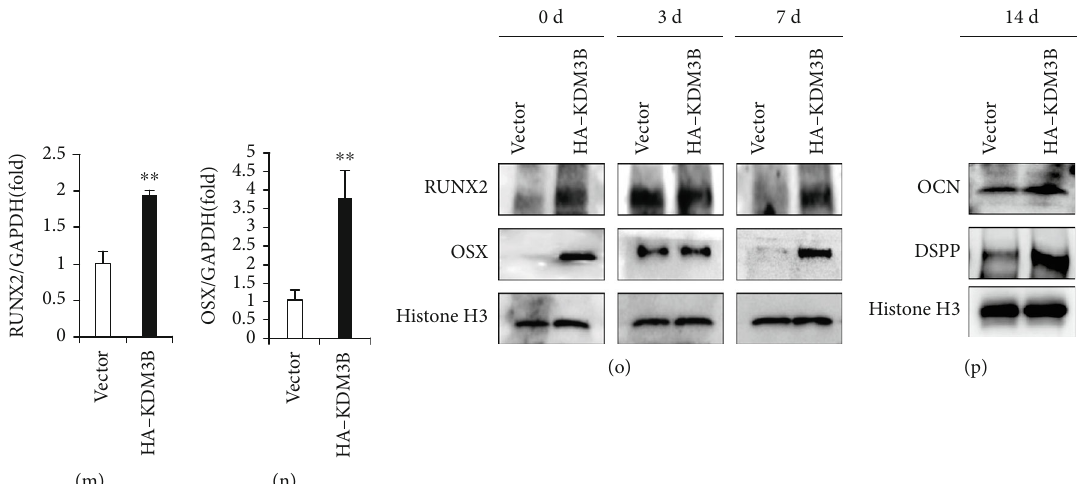
Figure 1: KDM3B enhanced the osteo-/odontogenic di ff erentiation potential of SCAPs. (a) The knockdown e ffi ciency of KDM3B in SCAPs was tested by western blot. (b) KDM3B knockdown signi fi cantly depressed the ALP activity in SCAPs. (c) The Alizarin red staining and (d) the quantitative calcium analysis showed that KDM3B knockdown reduced the mineralization capacity of SCAPs compared with the control group. (e, f) Real-time RT-PCR analysis con fi rmed that KDM3B knockdown reduced the expression of (e) RUNX2 and (f) OSX in SCAPs. (g) Western blot analysis showed the expression of RUNX2 and OSX in the KDM3B knockdown group and the control group. Histone H3 served as an internal control. (h) Western blot analysis revealed that the expression of DSPP and OCN was decreased after KDM3B was knocked down. Histone H3 served as an internal control. (i) The KDM3B overexpression was tested by western blot. (j) KDM3B overexpression signi fi cantly enhanced the ALP activity in SCAPs. (k, l) The results of (k) the Alizarin red staining and (l) the quantitative calcium analysis revealed that KDM3B overexpression enhanced the mineralization capacity of SCAPs compared with the control group. (m, n) Real-time RT-PCR analysis revealed that KDM3B overexpression increased the expression of (m) RUNX2 and (n) OSX in SCAPs. (o) Western blot analysis showed the expression of RUNX2 and OSX in the KDM3B overexpression group and the control group. Histone H3 served as an internal control. (p) Western blot analysis revealed that the expression of OCN and DSPP was enhanced after KDM3B was overexpressed. Histone H3 served as an internal control. Statistical signi fi cance was determined using Student ’ s t -test. All error bars represent SD ( n = 3 ). P < 0 : 05 . ∗∗ P ≤ 0 : 01